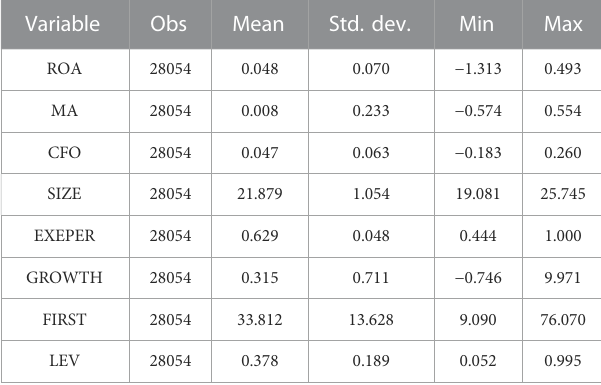
TABLE 1 Descriptive statistics.